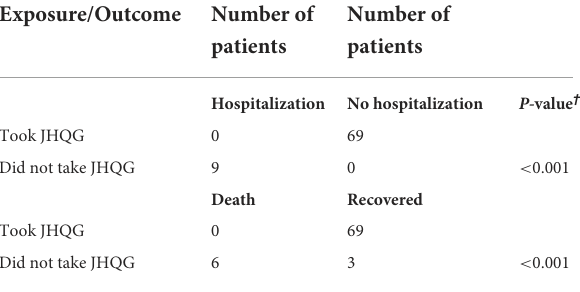
TABLE 2 Efficacy of JHQG in reducing hospitalization and mortality in high risk elderly patients.